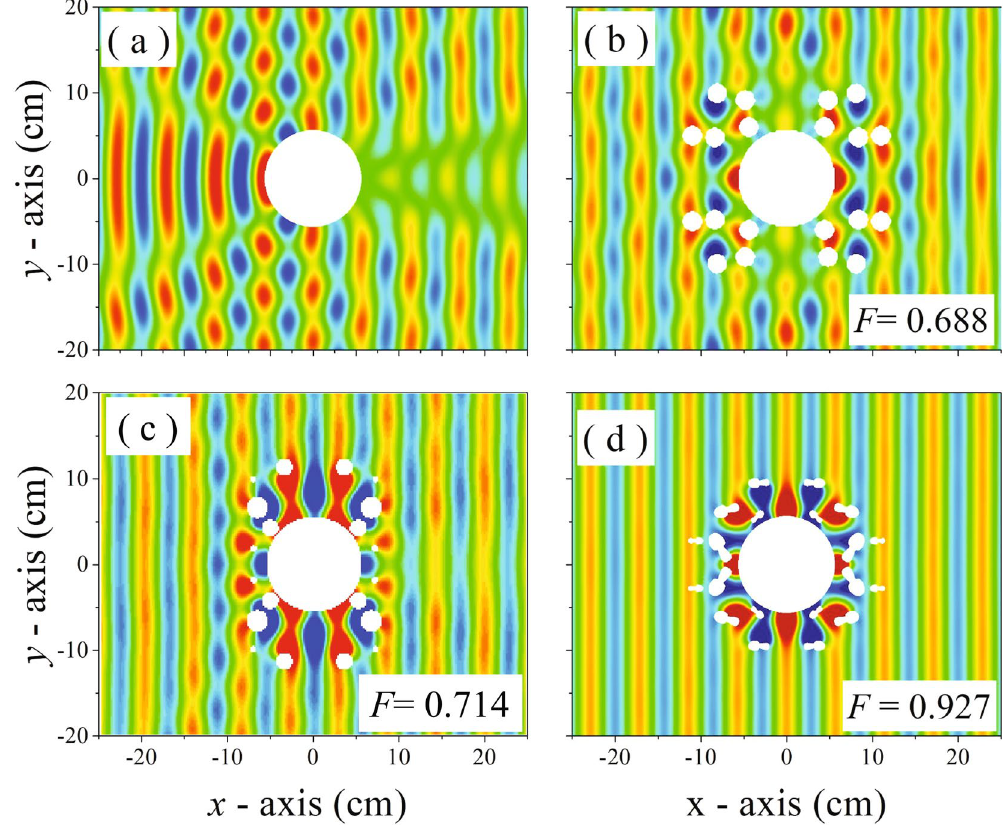
Figure 3. Total pressure maps obtained at 6 kHz from the interaction of a plane wave with: a cylindrical rigid object ( a ); the object with a cloak made of 20 circular cylinders with equal radii ( b ); the object with a cloak made with 20 cylinders with different radii ( c ); the object with a cloak made of 20 Bézier scatterers ( d